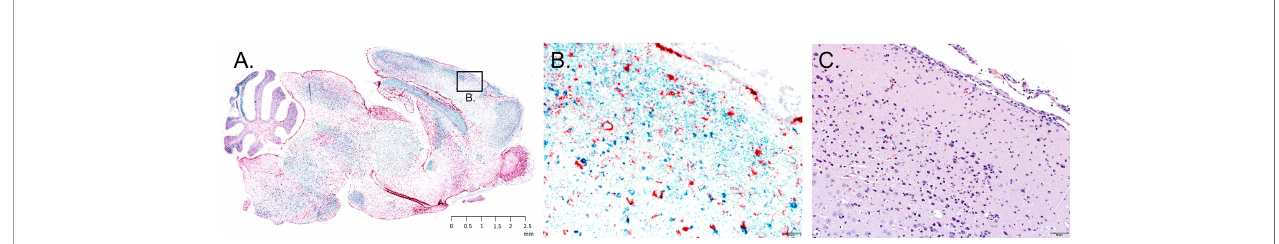
FIGURE 4 | Representative neuropathology in a mouse infested with POWV-infected H. longicornis . Mouse 6 was infested with an individual POWV II-injected adult female tick. (A) RNA in situ hybridization detection of POWV RNA (blue-green signal) and Mus musculus GFAP RNA (red signal) in the whole brain sagittal cross- section. Section was counterstained with hematoxylin. Scale bar = 2.5 mm. (B) Inset image of RNA in situ hybridization detection of POWV RNA and Mus musculus GFAP RNA in the cerebral cortex. Scale bar = 50 microns. (C) H&E stained cerebral cortex. Scale bar =